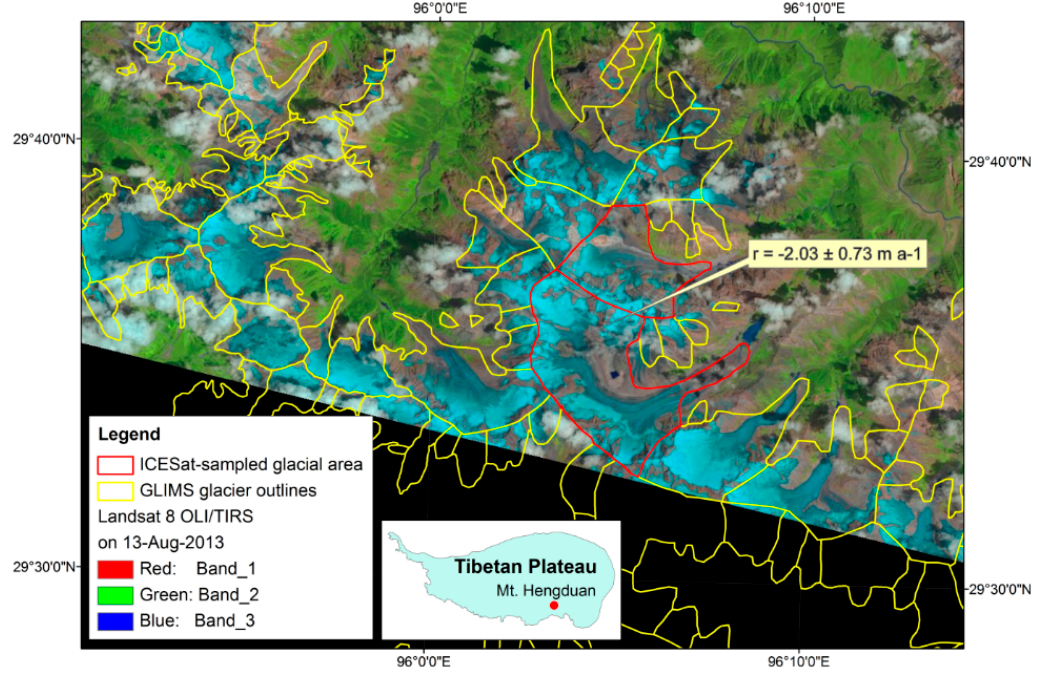
Figure 5. The maximal rate of glacial thickness decrease between 2003 and 2009 at Mount Hengduan. The figure is created by overlaying the GLIMS glacier outlines on the Landsat 8 OLI/TIRS image from 13 August 2013.